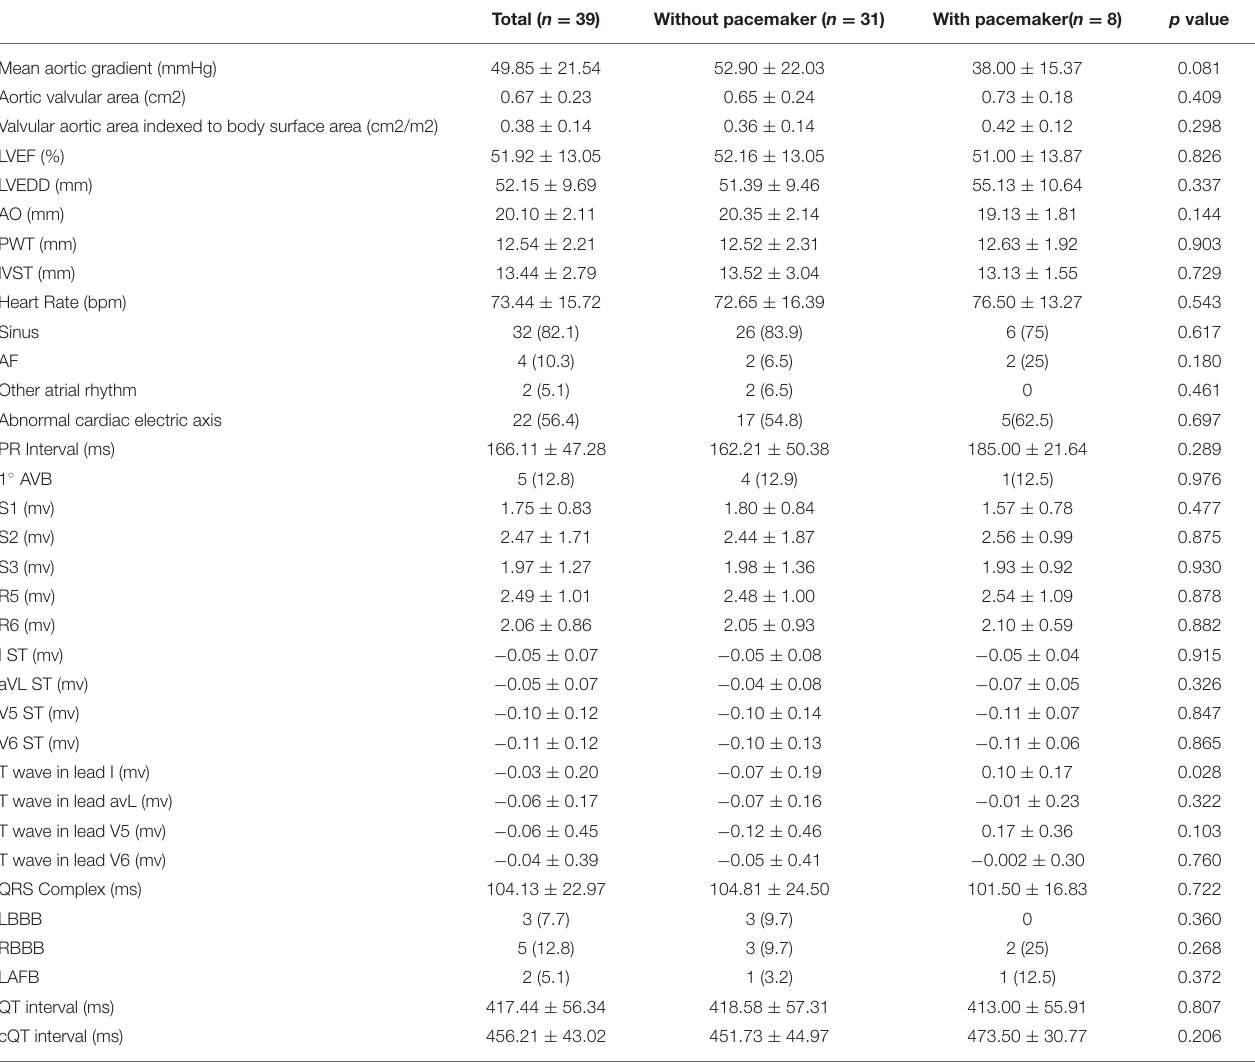
TABLE 2 | Echocardiographic characteristics and electrocardiographic